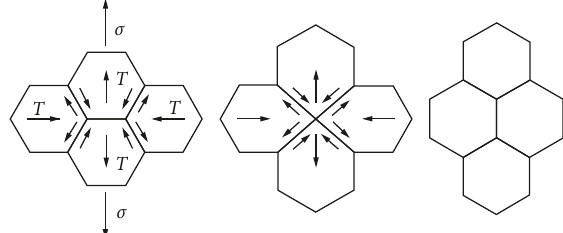
Figure 4: The Ashby–Verrall theoretical model for superplastic deformation. (a) Initial. (b) Intermediate. (c)